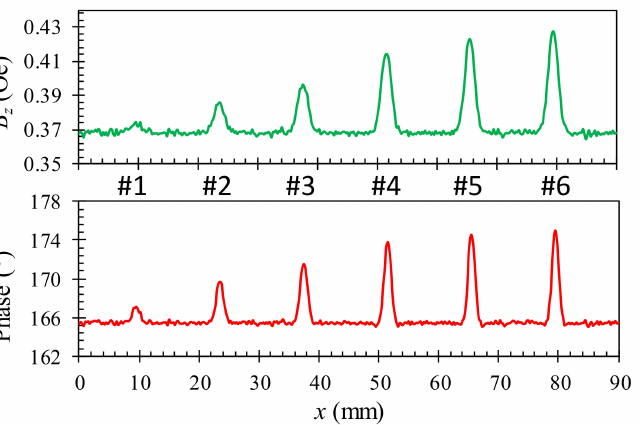
Figure 11. The eddy-current distribution following the depth of ( a ) a flawless aluminum sample and ( b ) a flawed sample at the excitation frequency of 40 kHz. The crack used in ( b ) has a 1.5 mm depth along the y -axis.